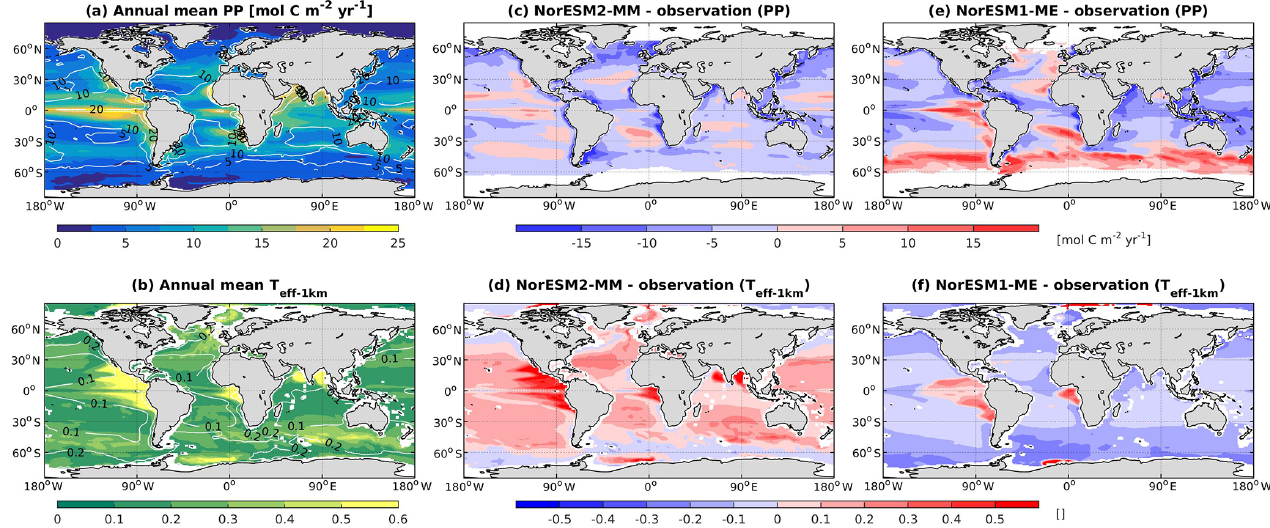
Figure 13. Annual mean (a) vertically integrated contemporary primary production and (b) transfer efficiency ( T eff-1km ) as simulated in NorESM2 (colour shadings) and from observations (contour lines). Respective difference between NorESM2-MM (NorESM1-ME) and observations are shown as colour shadings (contour lines) in panels (c) – (d) .